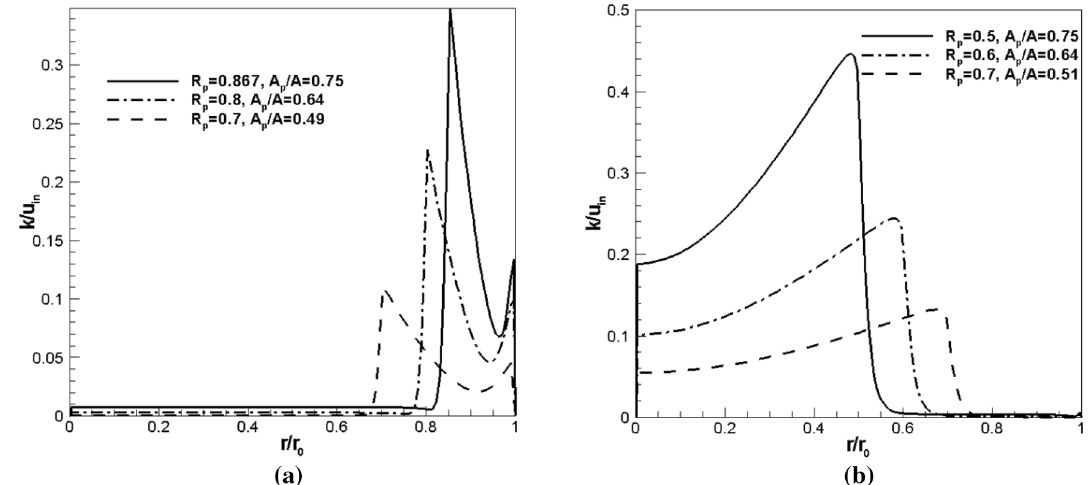
Fig. 12 Variation of TKE with filling ratio in a central arrangement, b boundary